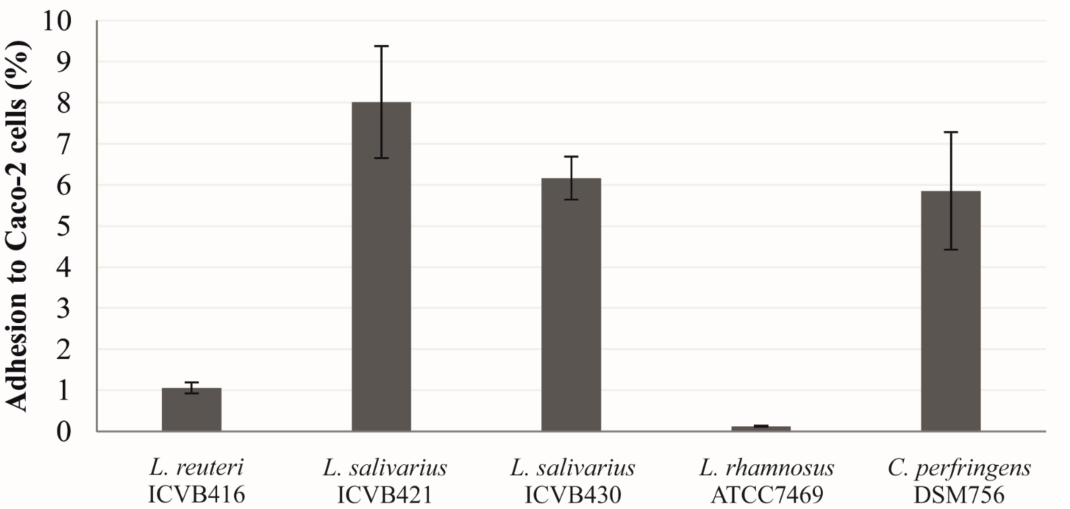
Figure 3. Adhesion percentage of Lactobacillaceae strains to eukaryotic Caco-2 cells as determined by quantitative PCR (qPCR).